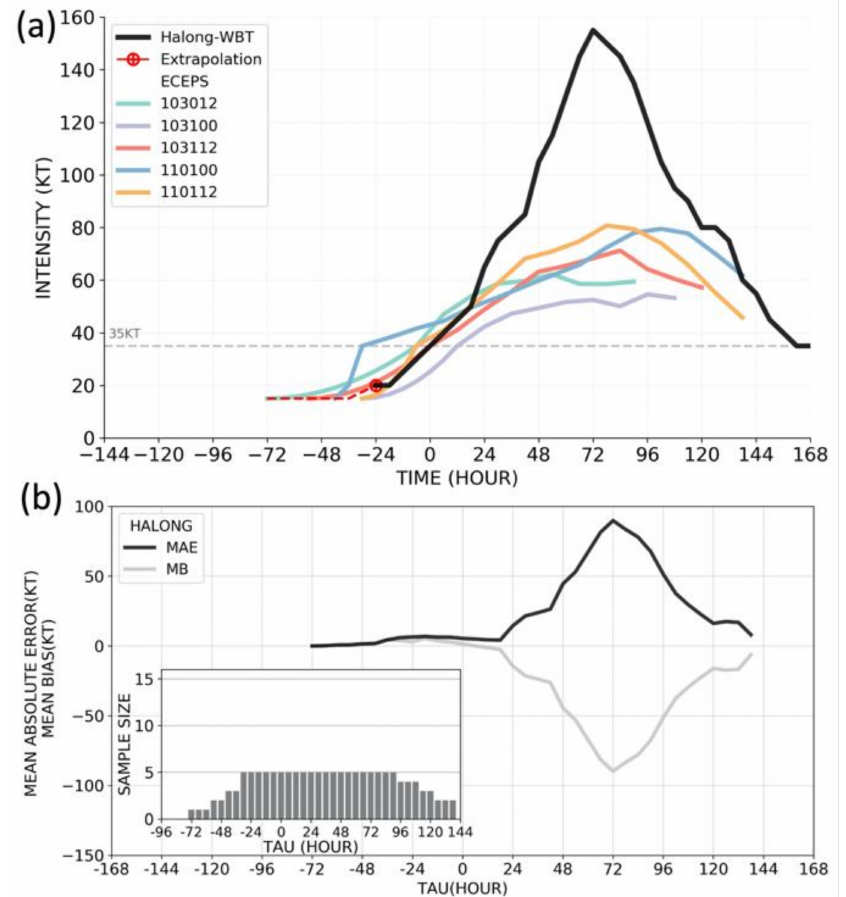
Figure A3. ( a ) Modified WAIP intensity (knots) forecast verifications for the ECEPS-predicted T2F (35 kt) as in Figure 5a, except for the pre-STY Halong (2019) circulations. ( b ) Intensity MAEs (solid line) and intensity MBs (gray line) as in Figure 5b, except for pre-STY